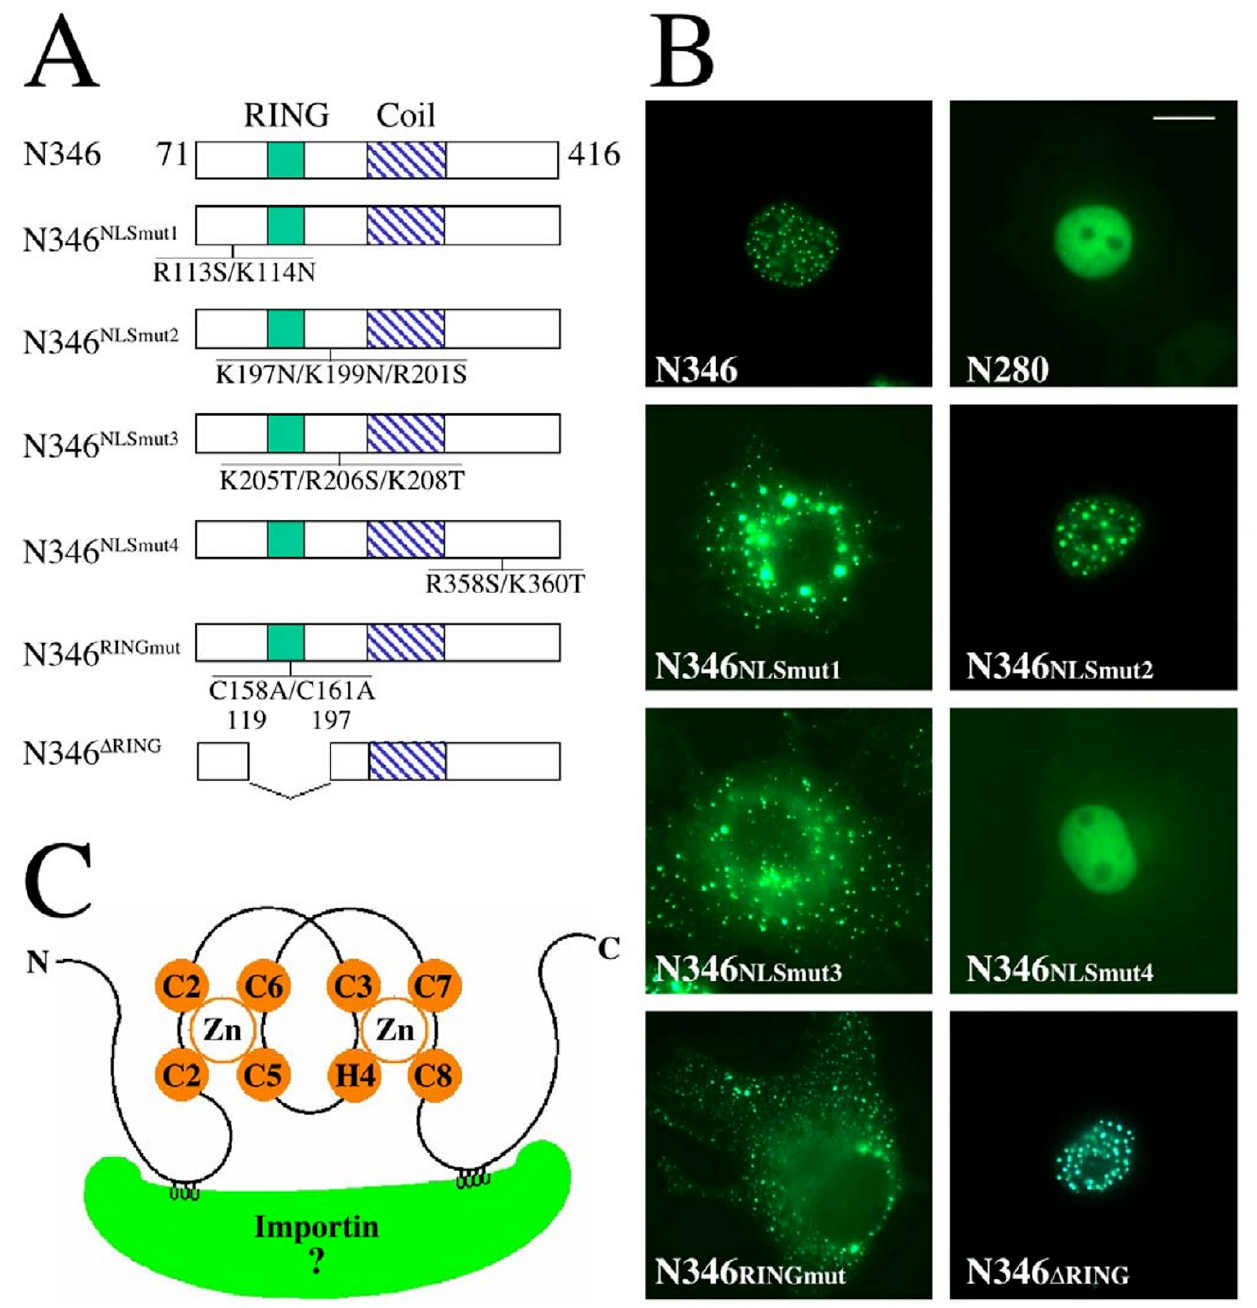
Figure 7 Mapping the nuclear localization signal of mammalian COP1 protein (A) Diagrams of the point-mutation and dele- tion-mutation constructs in GFP-N346 in comparison to the wild-type GFP-N346. The position and the amino acid replace- ments in each mutant protein are indicated. (B) GFP fluorescence study of the subcellular localizations of the mutant GFP- N346 proteins. The studies were carried out in COS7 cells. The same magnification was used for all images and the scale bar for 10 micrometer was indicated in the N280 image. (C) Schematic illustration of COP1 RING finger bridged bipartite nuclear localization signal (NLS) binding to importin. The two zinc atoms and zinc binding residues of COP1 RING finger are shown in orange. The two clusters of positively charged residues of COP1 NLS (in grey) bind to two binding pockets on the inner sur- face of importin (in